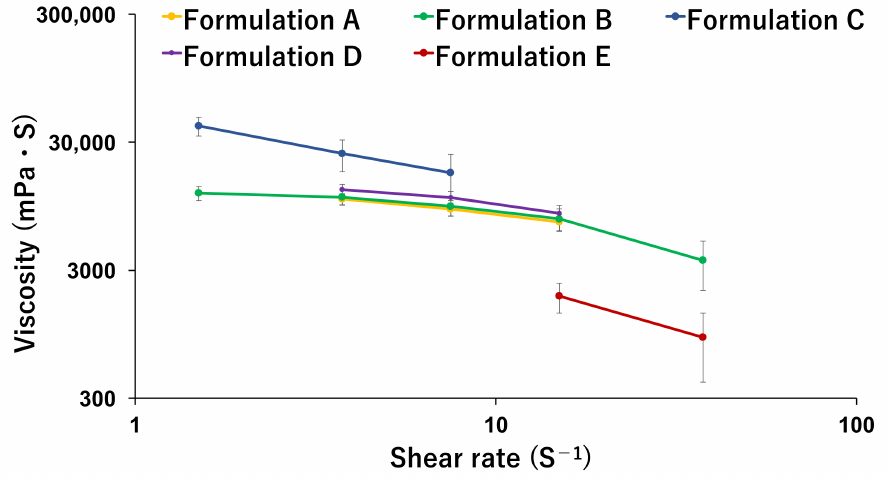
Figure 3. The viscosity of printer ink with different water/ethanol ratios. The composition is described in Table 1. The data are shown as the means ± SD ( n = 3).